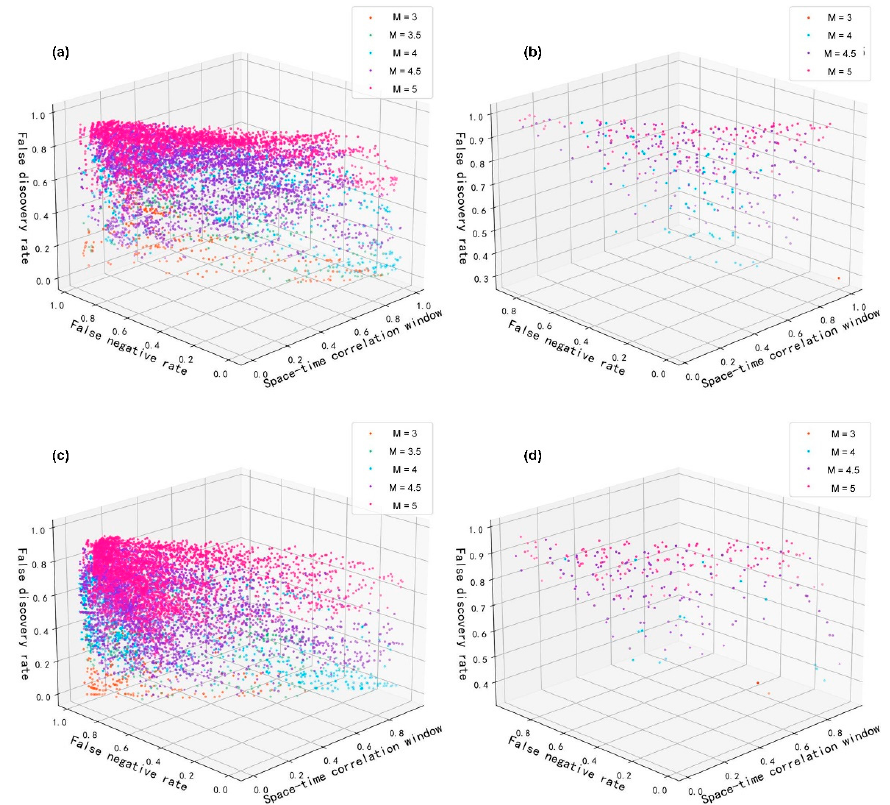
Figure 13. Moving windows comparing the results of the parameters that pass the significance test of the FDR and FNR simultaneously under different magnitude parameters in the experiments: ( a ) the model with a “heating core” when the moving window scale is 50 km, where a total of 7005 sets of parameters pass the test; ( b ) the model without a “heating core” when the moving window scale is 50 km, where a total of 355 sets of parameters pass the test; ( c ) the model with a “heating core” when the moving window scale is 100 km, where a total of 8421 sets of parameters pass the test; ( d ) the model without a “heating core” when the moving window scale is 100 km, where a total of 272 sets of parameters pass the test.